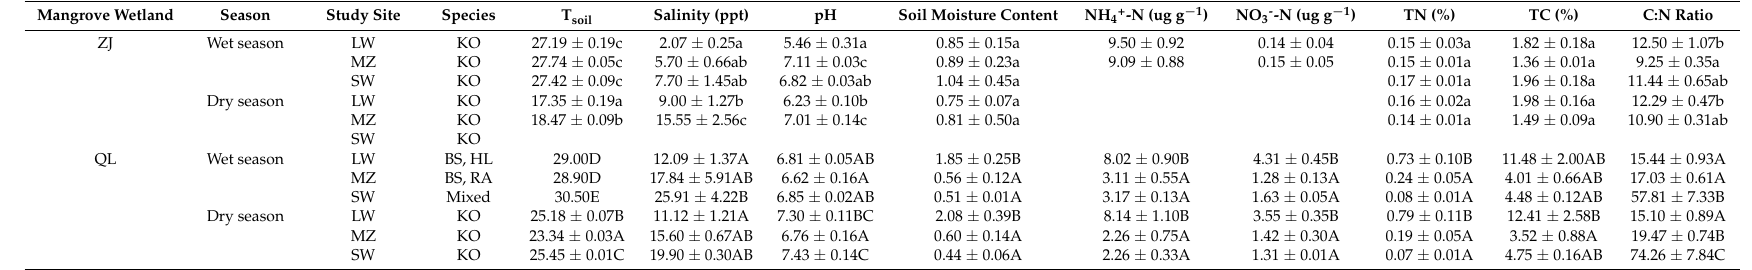
Table 1. Key characteristics for mangrove soils at various study sites measured during wet and dry